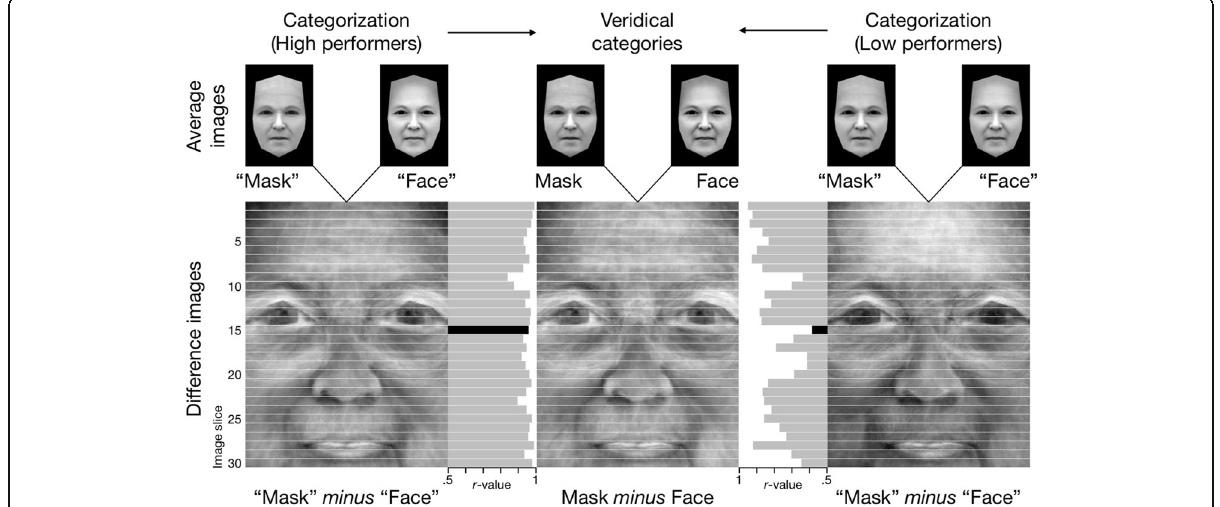
Fig. 9 Summary image analysis in Study 3. Average images show mean pixel intensities across images in each category, separately for high performers ( left ), low performers ( right ), and veridical categories ( center ). Difference images are subtractions of pixel intensity (mask minus face; rescaled for visualization). Lighter colors indicate larger differences. Note the light region around the eye in the veridical difference image. The y-axis shows 30 horizontal image slices. Correlations between difference images ( gray bars ) are shown for each image slice. The largest discrepancy between high and low performers is shown at Slice 15 ( black bars ). High performers closely tracked categorial differences in this region. Low performers did